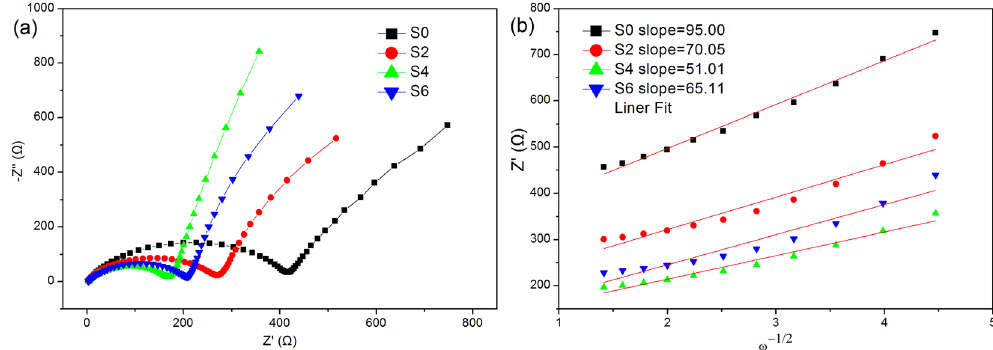
Figure 5. EIS results of electrodes. ( a ) Nyquist plot of the EIS of coin cells, ( b ) the linear relationship between the Warburg impedance and the inverse square root of angular frequency, the slopes of the simulated lines are the Warburg constant for the samples.